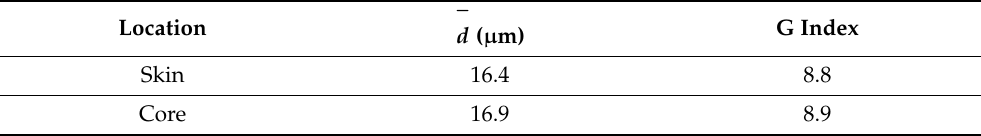
Figure 5. Metallographic observations after Nital etching in: ( a ) the skin (A4) and ( b ) core (C4) parts. Table 3. Mean grain size in the skin and in the core of the ingot. d designates the average equivalent grain